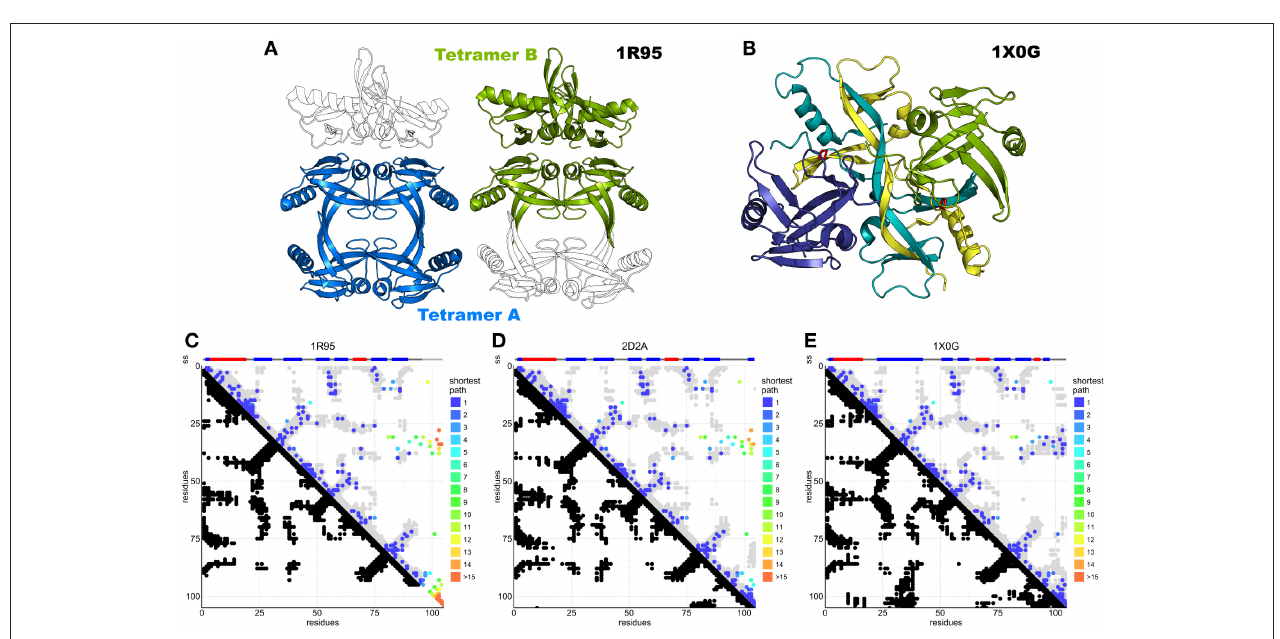
FIGURE 5 | DCA analysis of IscA superimposed on available structures. (A) IscA reference structure 1R95 with the two proposed tetramerization interfaces. The tetramer A (left) is the most broadly accepted biological unit. (B) Domain swapped IscA tetramer (1X0G) bound to the FeS cluster. In shades of blue and green the two dimers. (C) DCA predictions compared to the 1R95 reference structure. Most predictions are accurate, but the missing C-terminus hinders interpretation of the cluster-binding site. DCA predictions compared to 1S98 are nearly identical and not shown. (D) DCA predictions compared to the SufA 2D2A reference structure. Most predictions are accurate, but the model shows relevant differences in the C-terminus and for contacts between the terminal cysteine and the Cys35 regions. (E) DCA predictions compared to 1X0G with domain swapping. Nearly all predictions match the structure.